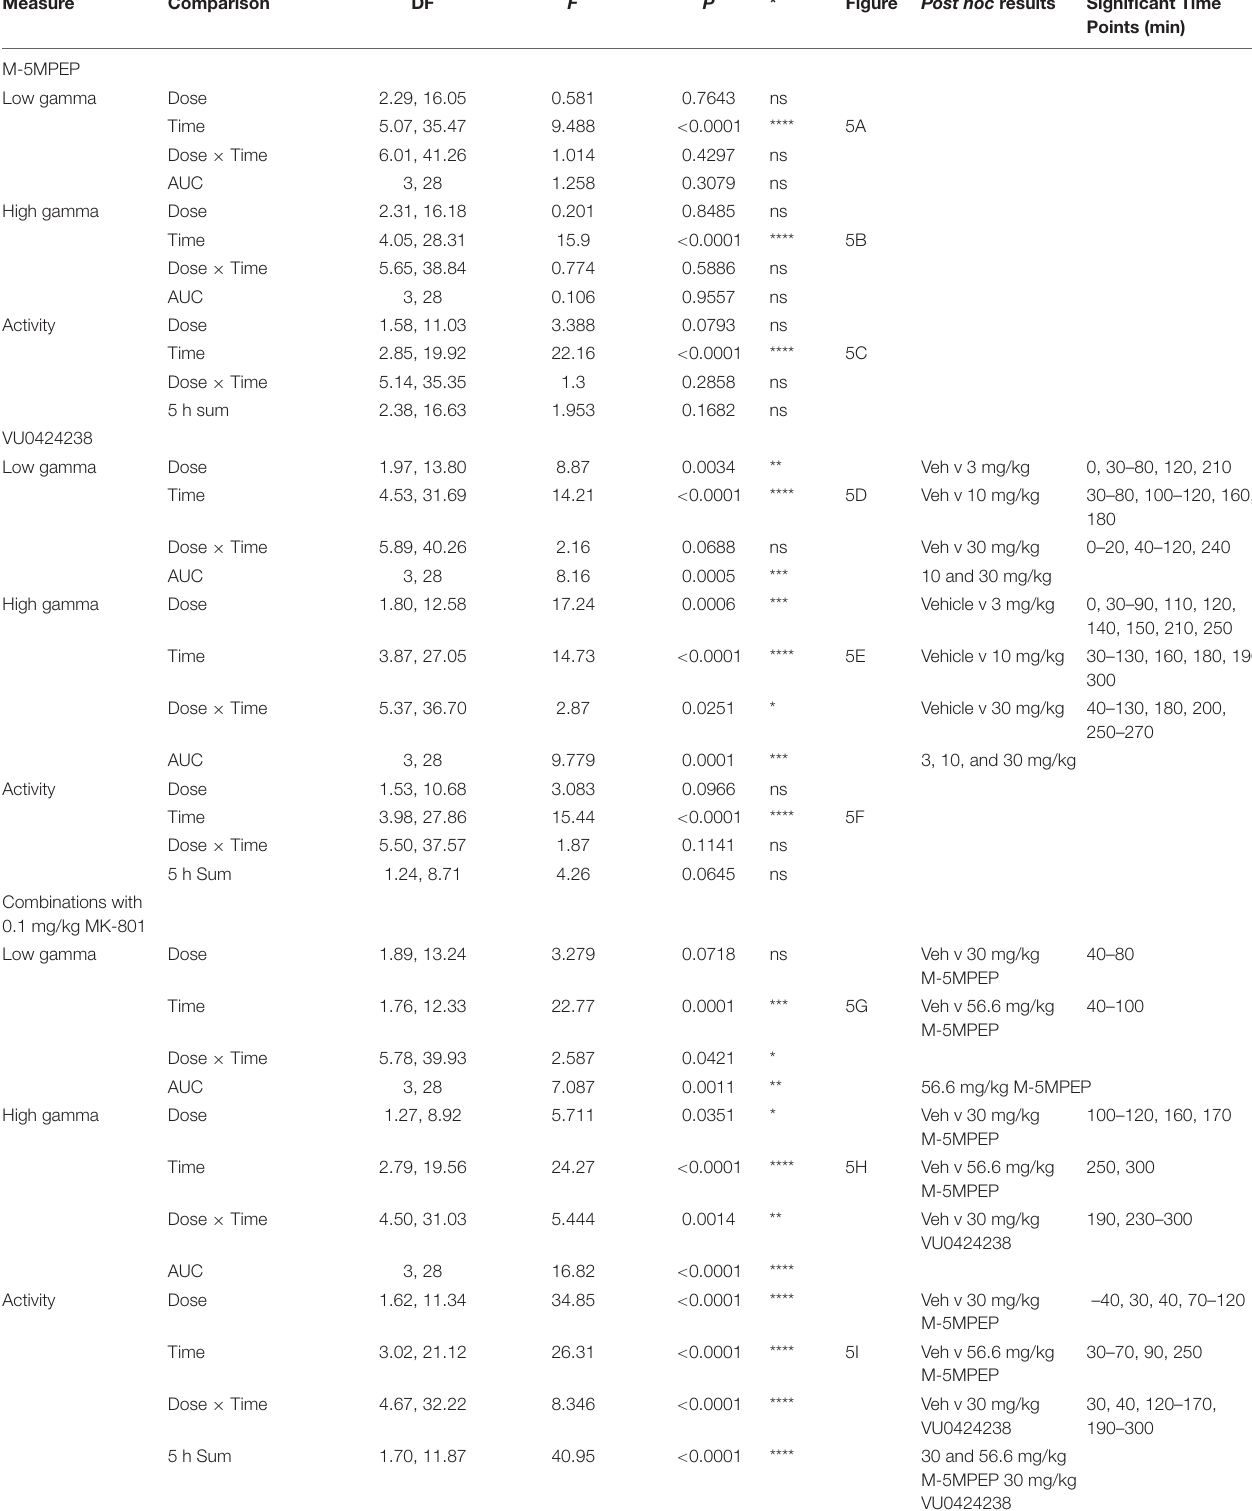
TABLE 2 | Statistics for Figure 5 .